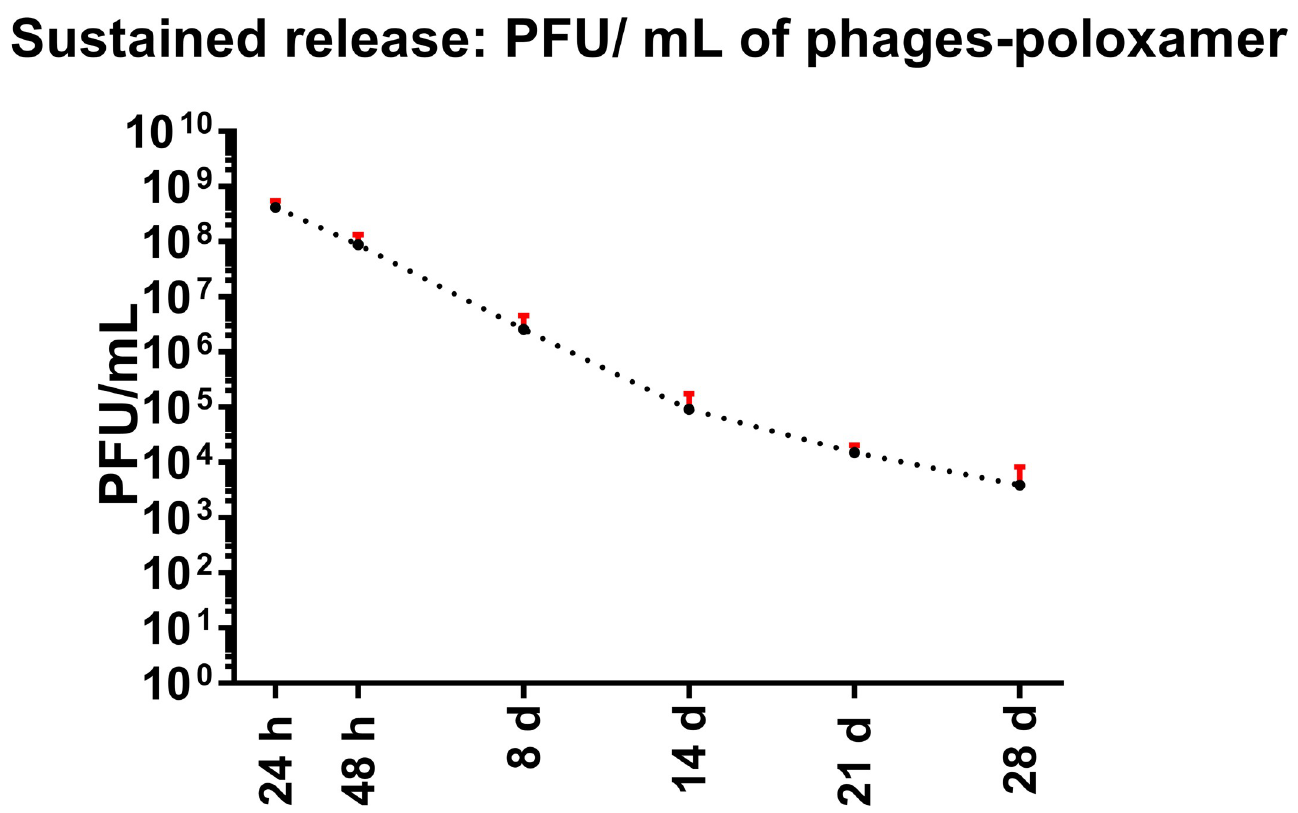
Fig 2. Poloxamer-phage cocktail releases active anti- E . faecalis phages for a month. PFU/mL of the EFDG1/EFLK1 phage cocktail released from 30% poloxamer-phage formulation measured after 1, 2, 8, 14, 21 and 28 days. Phage release was measured for a month. A high concentration of phage release was observed during the test period, and the phage concentration of the solution gradually decreased from 10 9 to 10 3 PFU/mL. The results are based on 5 independent biological replicates.